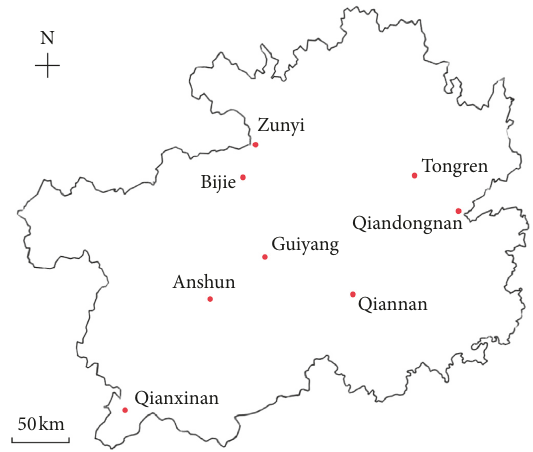
Figure 1: The geographical origin map of sauce-flavor baijiu (Chinese baijiu) samples from Guizhou